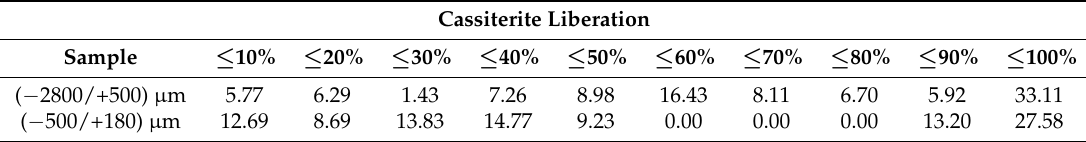
Table 4. Cassiterite liberation. 80% liberation is required for mineral processing.